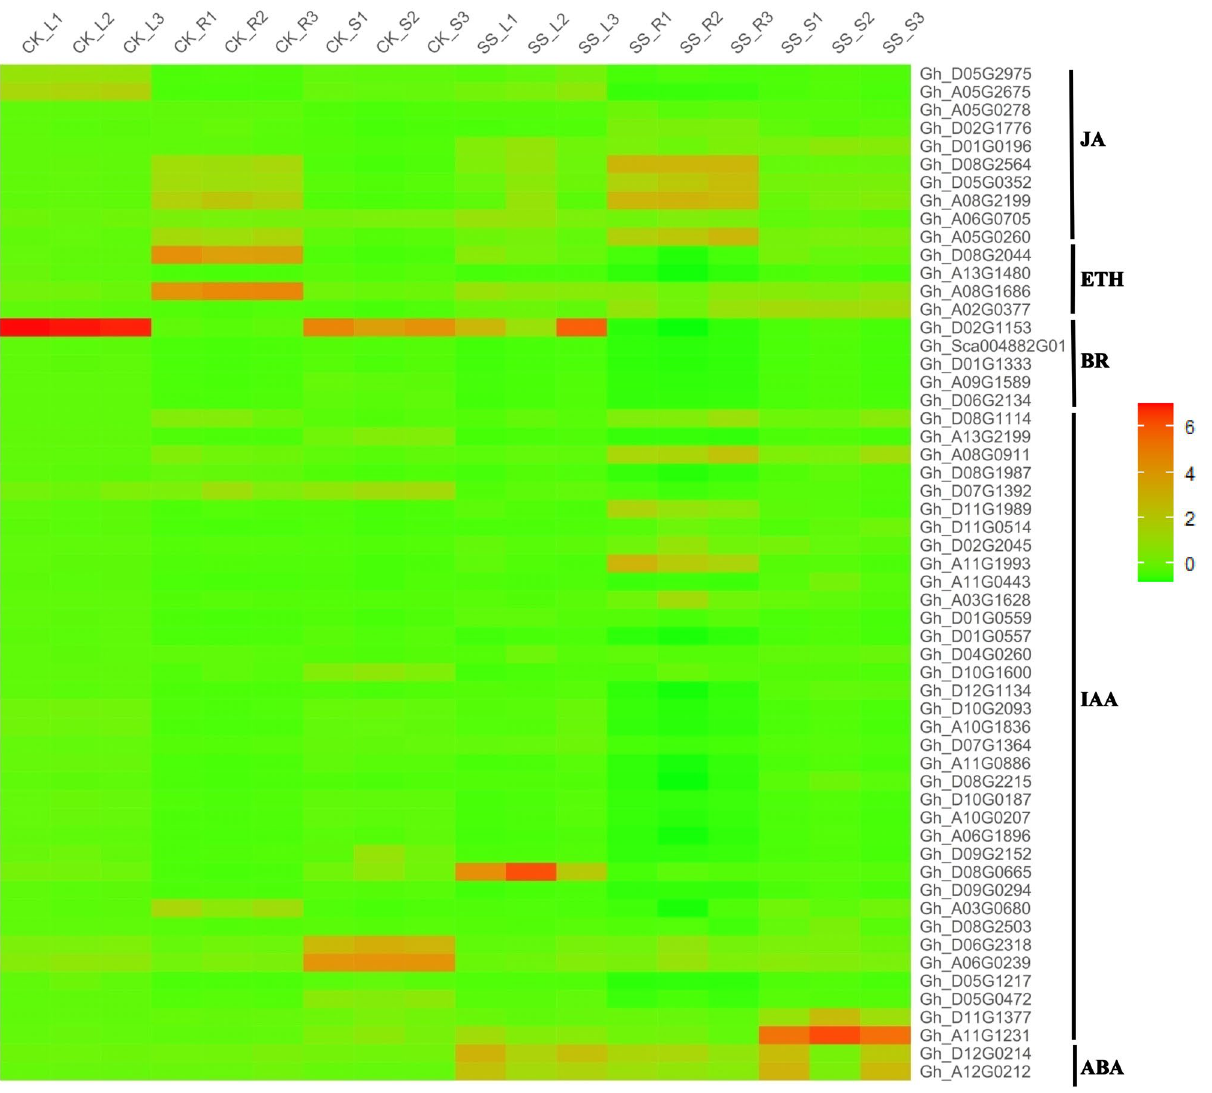
Figure 7. Heatmap of the standardized FPKM expression level of the DEGs related to hormones enrichment among roots, stems and leaves between SS and CK drawn by ggplot2 (v3.3.3). CK: Control group; SS: 300 mM Na 2 SO 4 . Red = high expression level of genes, and Green = low expression level of